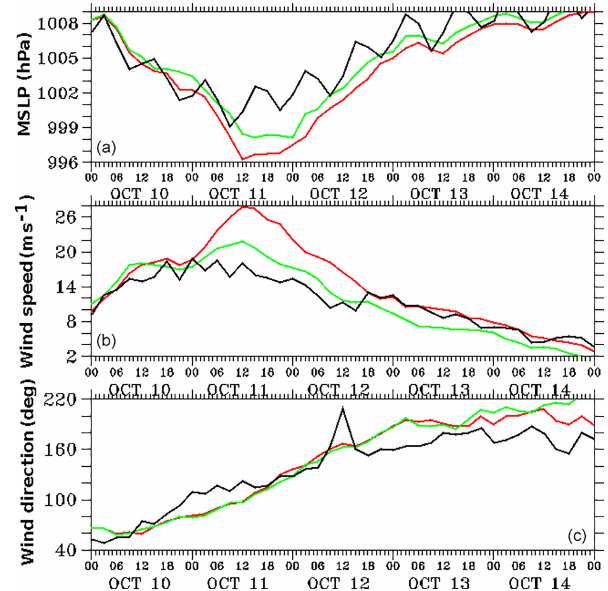
model (red), and observations from a buoy BD09 (black) for the (a) mean sea level pressure (hPa), (b) wind speed (ms − 1 ) , and (c) wind direction